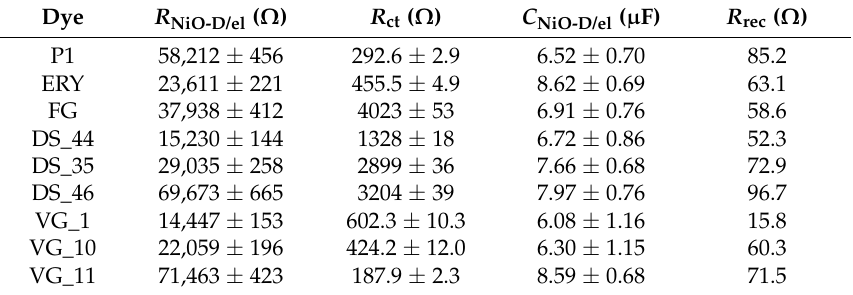
Table 2. List of the fitting values of R NiO-D/el , R ct , and C NiO-D/el for the simulation of the impedance spectra of the cells with sensitized NiO electrodes at the condition of open-circuit potential. The meaning of the terms R NiO-D/el and R ct is the same as reported in the caption of Figure 10. C NiO-D/el is the capacitance of the double layer at the sensitized NiO/electrolyte